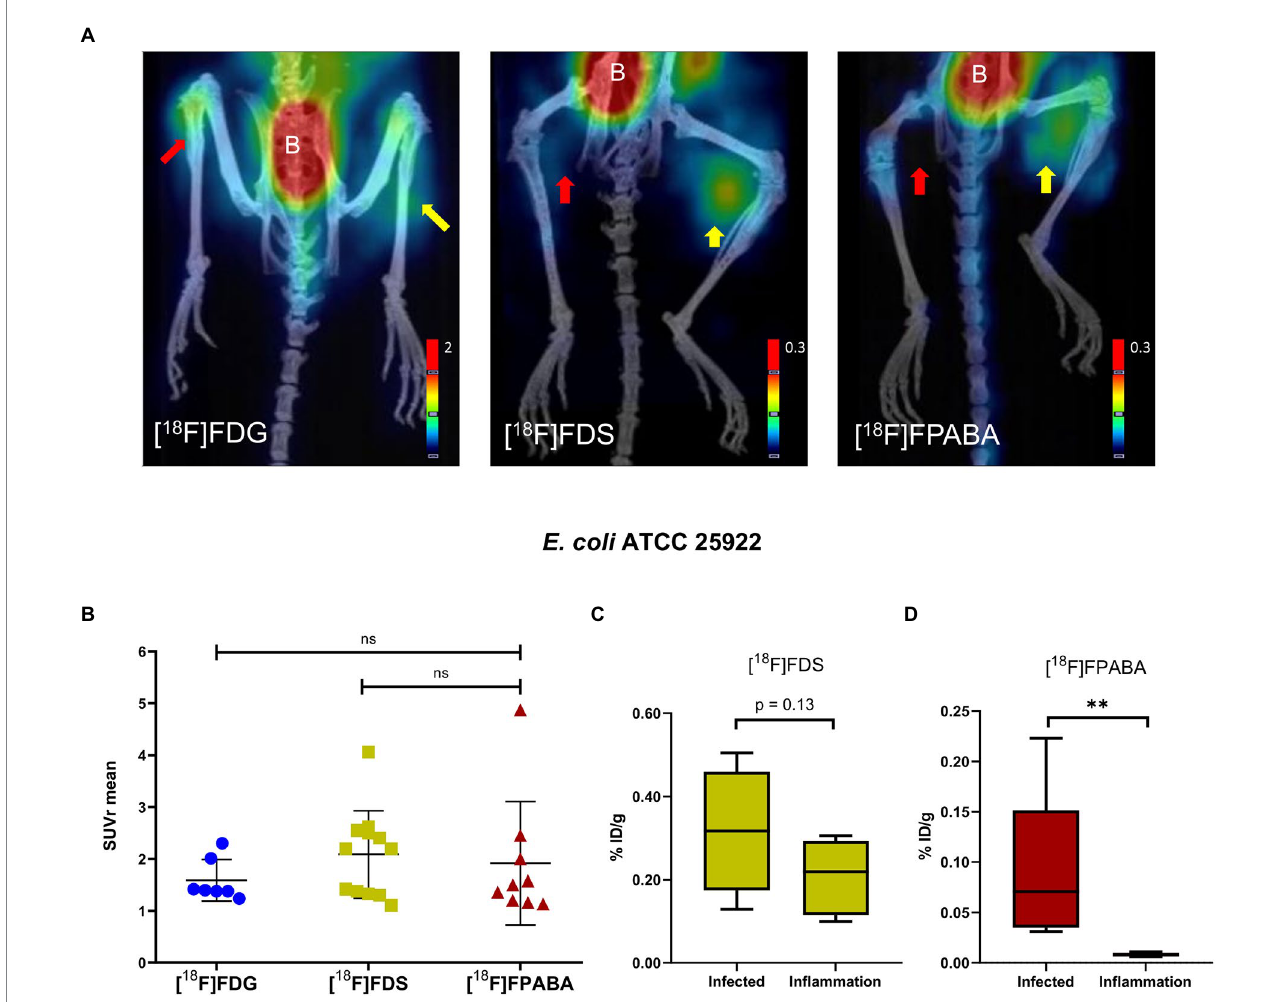
FIGURE 5 Escherichia coli myositis infection and inflammation of the hindlimbs. (A) PET/CT image of [ 18 F]FDS ( n = 12) after 120 min, [ 18 F]FDG ( n = 7), and [ 18 F]FPABA ( n = 9) after 60 min of uptake. The right limb was infected with exponentially growing bacteria (yellow arrow); the left limb was injected with heat-killed bacteria (red arrow). B = bladder. (B) Comparison of mean SUVr for uptake of [ 18 F]FDG, [ 18 F]FDS, and [ 18 F]FPABA in infected and inflamed muscle tissue. Represented as mean ± SD. ns, not significant ( p > 0.05). Kruskal-Wallis multiple-comparison test. (C) Ex vivo comparison of % injected dose of [ 18 F]FDS per gram of infected versus inflamed tissue (%ID/g). (D) Ex vivo comparison of % injected dose of [ 18 F]FPABA per gram of infected vs. inflamed tissue (%ID/g). ** p ≤